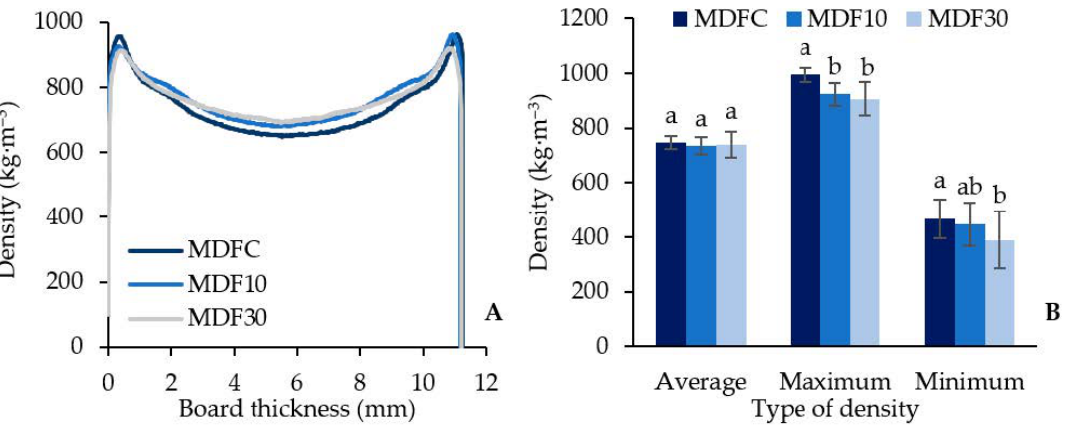
Figure 1. Density of MDF panels. ( A ) Density profiles of the average of eight samples of MDF panels. ( B ) Types of density of the panels obtained from the X-ray densitometry. Different lowercase letters represent statistically significant difference among panels by Tukey test ( p ≤ 0.05).